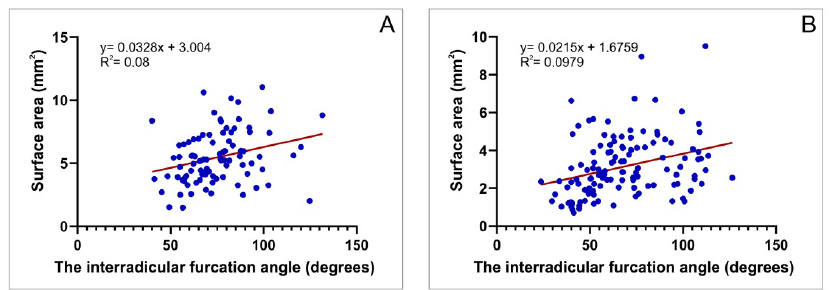
Figure 9. The correlation between the interradicular furcation angle and surface area at the level A: ( A ) the first maxillary molars and ( B ) the second maxillary molars. ( A ) the first maxillary molars and ( B ) the second maxillary